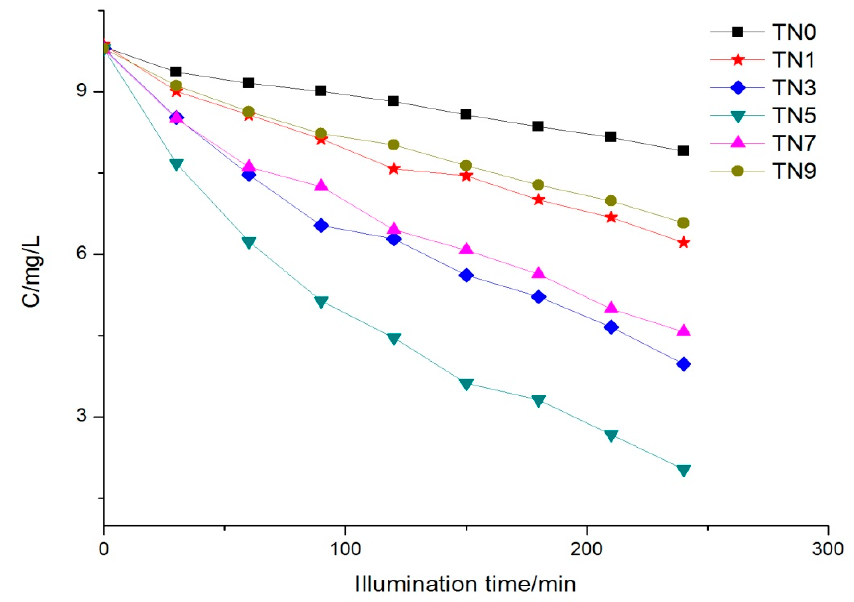
Figure 6. Phenol concentration trend under visible light.